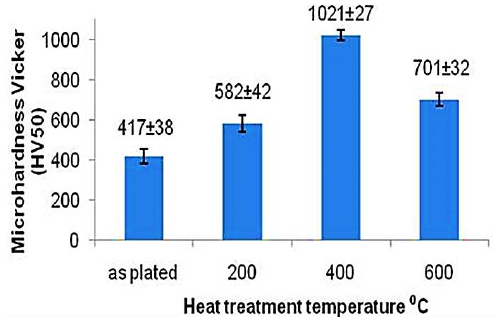
Figure 3. The microhardness of NiPPA nano-dispersion coatings at different temperatures.